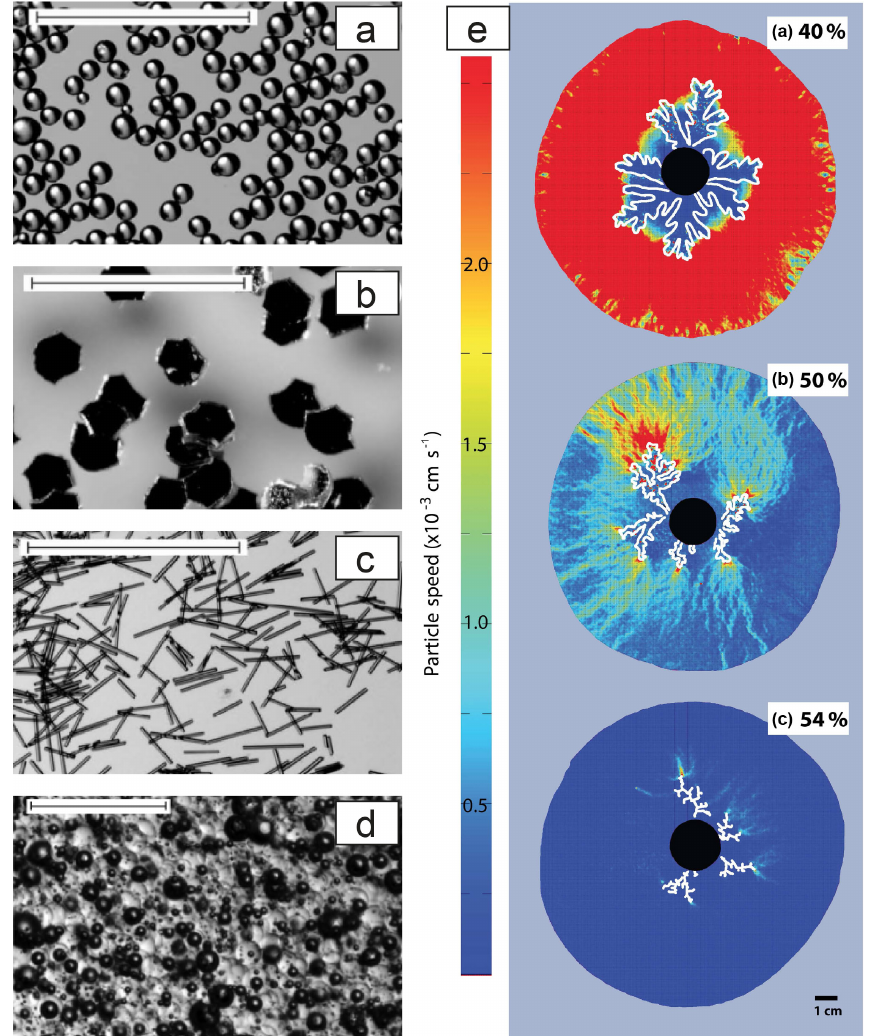
Figure 6. Magma rheology studied using analogue materials in laboratory experiments. (a–c) Spherical glass beads, oblate art glitter, and prolate glass fibres in silicone oil (scale bars 1mm; Mueller et al., 2011); (d) three-phase fluid in which bubbles (black spheres) and spherical glass beads (light translucent particles) are suspended in golden syrup (scale bar 500µm; Truby et al., 2015). (e) Bubble injection experiments using a small-gap parallel-plate geometry to study the development of permeable pathways in a particle-rich suspension. Particle image velocimetry has been used to measure particle speed in three experiments with different crystal fraction (Oppenheimer et al.,